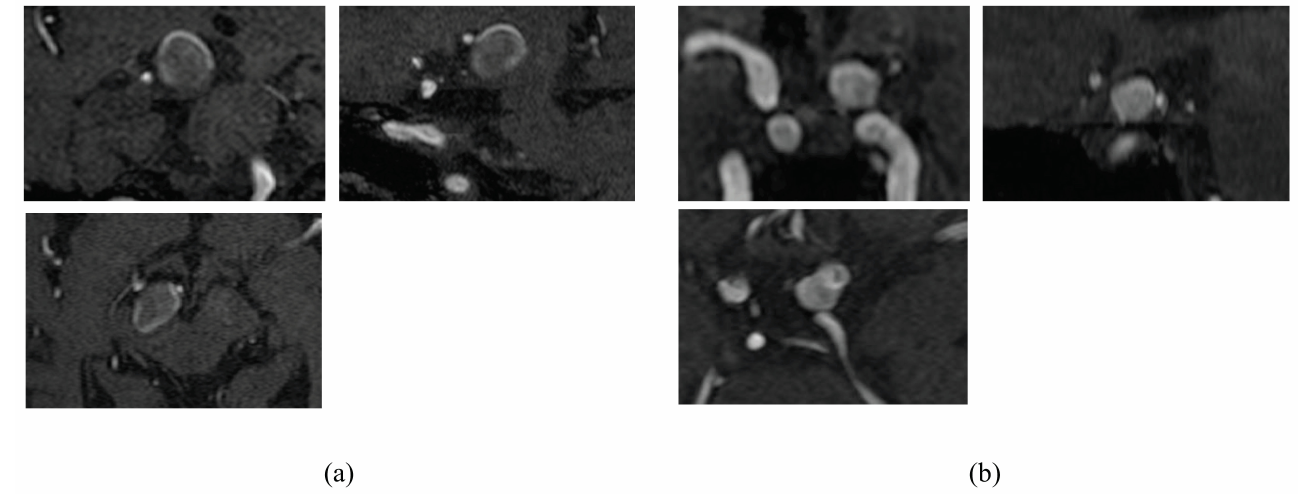
Figure 5. MRA images of intracranial aneurysms: ( a ) an RA case; ( b ) a UA